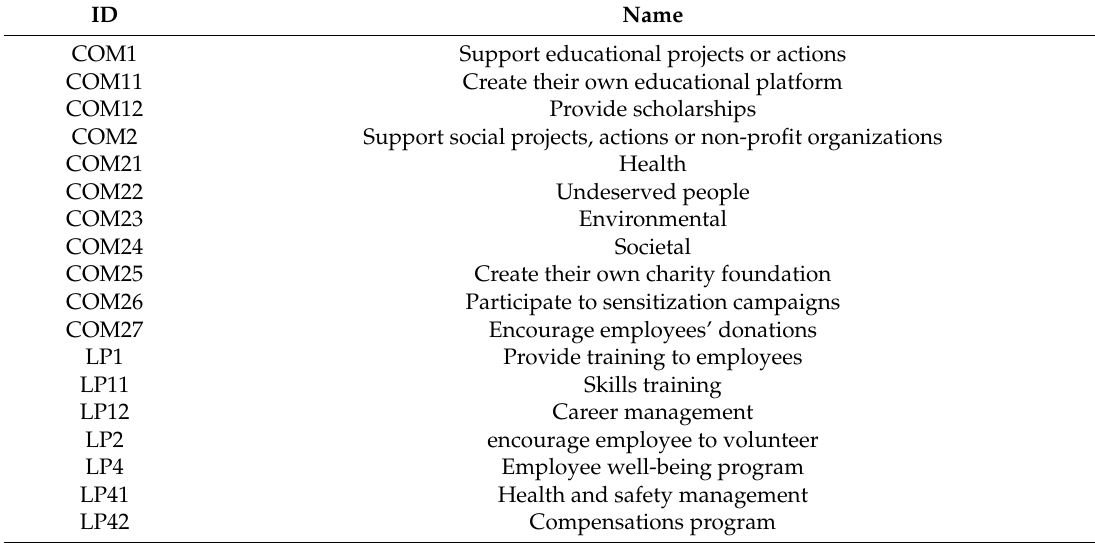
Table 8. The list of all the patterns and their related additional components extracted at the end of our